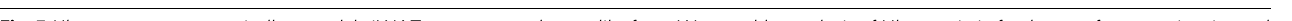
Fig. 5 Hlx transgene systematically remodels iWAT to generate a brown-like fat. a Western blot analysis of Hlx protein in fat depots of transgenic mice and control mice. b Mice were intraperitoneally injected with a single dose of CL-316,243, or placed at 4 °C for 6 hr. Hlx protein levels in iWAT were compared with that of Hlx transgenic mice. c Body weights of 10-week-old male ( n = 4 – 5 per group). d Fat mass of mice shown in ( c ). White bar , wild type; Blue bar , transgenic mice. e Representative images of BAT, iWAT and eWAT. f H&E staining of iWAT and eWAT of 12-week-old mice. Scale bar, 200 µ m. g Ucp1 immuno fl uorescence staining of iWAT and eWAT of 12-week-old mice. Shown are representative images of three mice per genotype. Green , Ucp1; Blue , DAPI. Scale bar , 200 µ m. h Daily food intake of 12-week-old male mice ( n = 5 per group). i 1293 signi fi cantly upregulated genes ( left ) and 1005 signi fi cantly downregulated ( right ) genes were identi fi ed in the iWAT of Hlx transgenic mice. In wild type mice, these genes have either similar expression between BAT and eWAT, higher expression in BAT, or higher expression in eWAT. Shown are distributions of these genes. j Distribution of BAT-selective ( left ) and WAT-selective genes ( right ) based on how they are regulated in the iWAT by the Hlx transgene. k Heat maps of relative expression levels of top BAT- selective genes, WAT-selective genes and common fat genes in iWAT of Hlx transgenic mice vs. control mice. l Heat maps of relative expression levels of mitochondrial β -oxidation enzymes and electron transfer chain components that were signi fi cantly upregulated by at least 2-fold in the iWAT of transgenic mice. m Mitochondrial density ( n = 3 mice per genotype). Bar , 1 µ m. n Relative mitochondrial DNA content by qPCR ( n = 4 mice per genotype). o CD31 immuno fl uorescence staining of iWAT of 12-week-old male mice. Shown are representative images of three mice per genotype. Green , CD31; Blue , DAPI. Scale bar , 200 µ m. All error bars represent s.e.m. Two-tailed unpaired Student ’ s t-test was performed. * p < 0.05; ** p < 0.01; *** p <